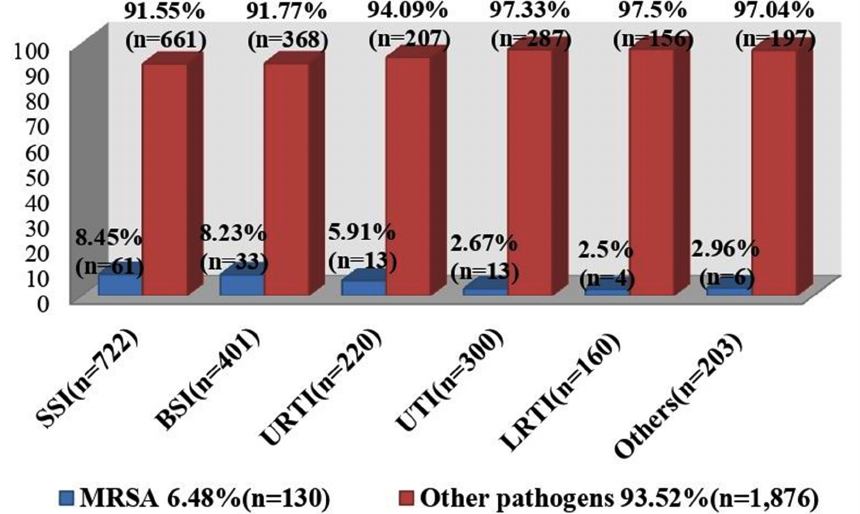
Fig. 3. Distribution of MRSA isolates according to the type of nosocomial infection in MUHs: Surgical site infection (SSI) was the most prevalent (8.45 %) followed by blood stream infection (BSI), upper respiratory tract infection (URTI) urinary tract infection (UTI), then lower respiratory tract infection